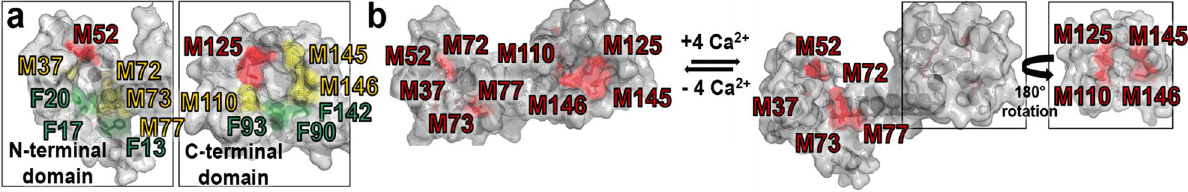
Figure 1. Hydrophobic interactions stabilize CaM’s EF hand domains. ( a ) N- and C-terminal domains of Ca 2+ -bound (holo) CaM (PDB 1CLL) with Met residues shown in yellow, Phe residues shown in green and the mutation sites 52 and 125 shown in red. ( b ) Ca 2+ binding alters the solvent exposure of CaM’s Met residues (red; PDB 1DMO 30 and 1CLL 31 ). For simplicity, residue assignment includes initiator Met. The image was generated using PyMOL Molecular Graphics System, Version 1.8 32 (https ://pymol